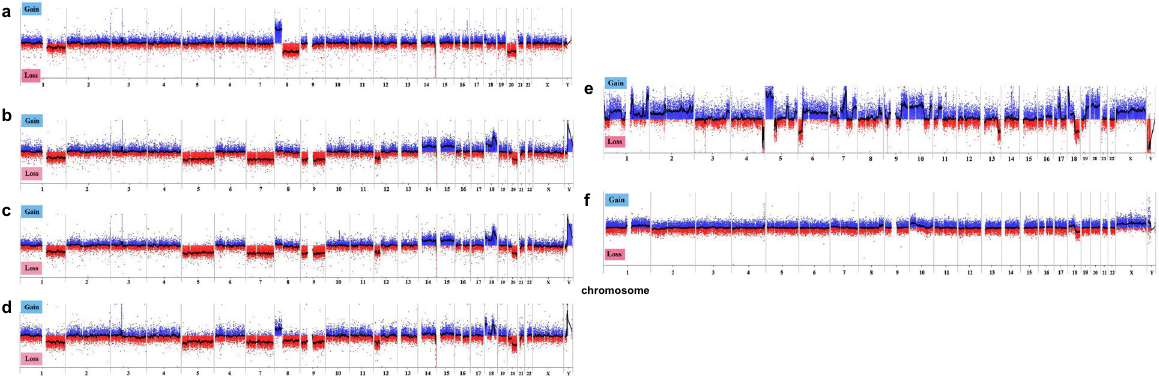
Figure 4. Copy number changes in CP-A and OACP4C cell lines when exposed to acid and deoxycholic acid in cell lines. Copy number changes were explored using microarray-based comparative genomic hybridization (array CGH). Representative copy number alterations identified in CP-A ( a–d ) and OACP4C ( e , f ). Copy number alterations before treatment with acid and DCA ( a , e ) and when treated with acid and DCA ( b – d , f ). Genomic DNA from each cell line without acid or DCA was labeled with Cy5-dUTP and compared to a Human Male Reference DNA (Agilent), labeled with Cy3-dUTP (i.e., naïve CP-A vs reference). Genomic DNA of each cell line treated with acid and DCA was labeled with Cy5-dUTP and compared to that of corresponding cell line treated without acid or DCA, which was labeled with Cy3-dUTP (i.e., CP-A treated with acid and DCA vs naïve CP-A). Copy number alterations at specific chromosomes were observed in CP-A and they were identical at different passage numbers ( b – d ) whereas these changes were rarely seen in OACP4C before and after treatment with acid and DCA ( f ). Gains are shown as blue lines in the upper area and losses are red lines in the lower area, respectively. Numbers represent the chromosome number. In each chromosome area, the short arm is located on the left side, and the long arm is on the right